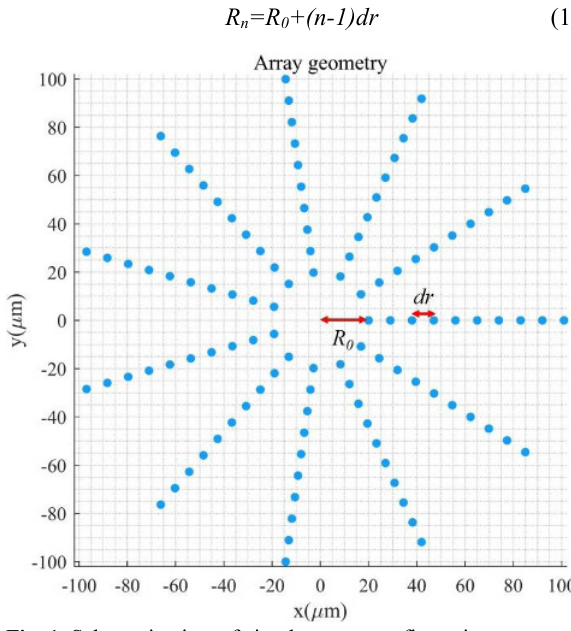
Fig. 1. Schematic view of circular array